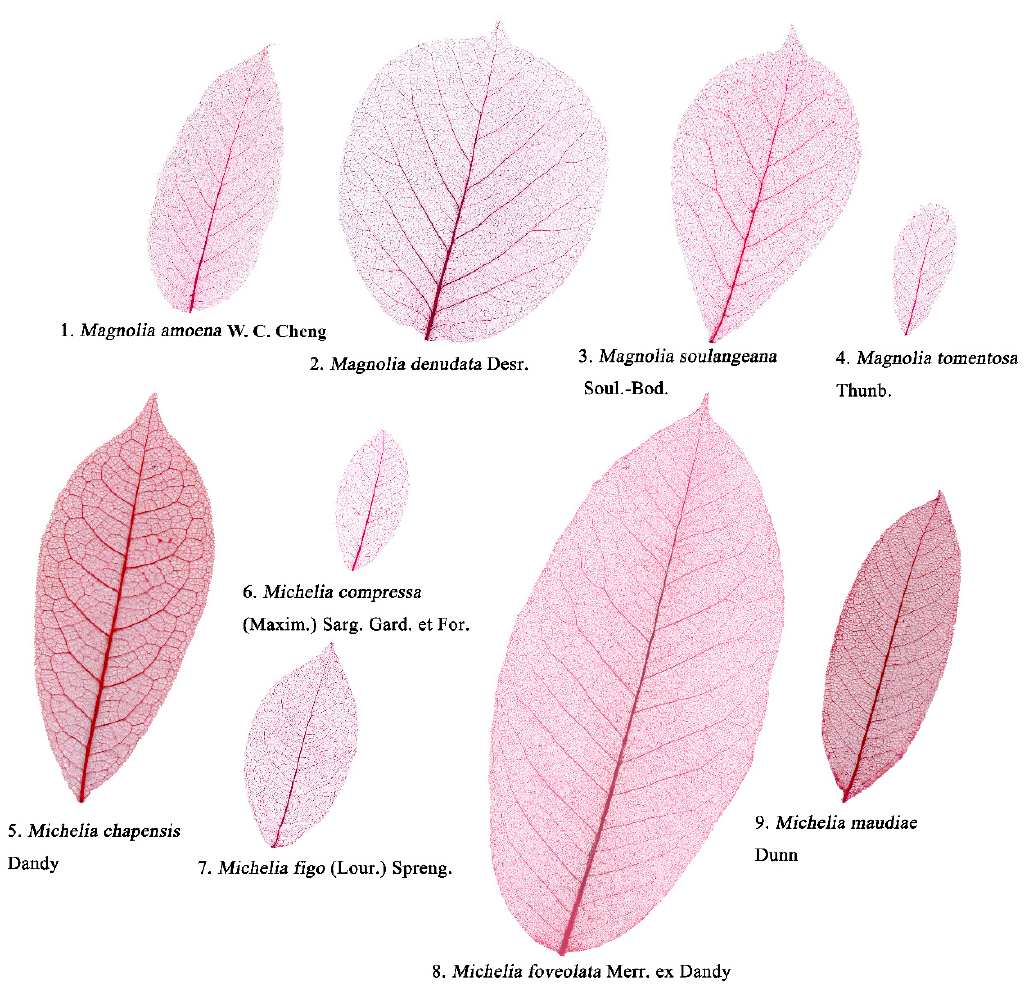
Figure 1. Examples in chemically-cleared leaves of nine Magnoliaceae species.